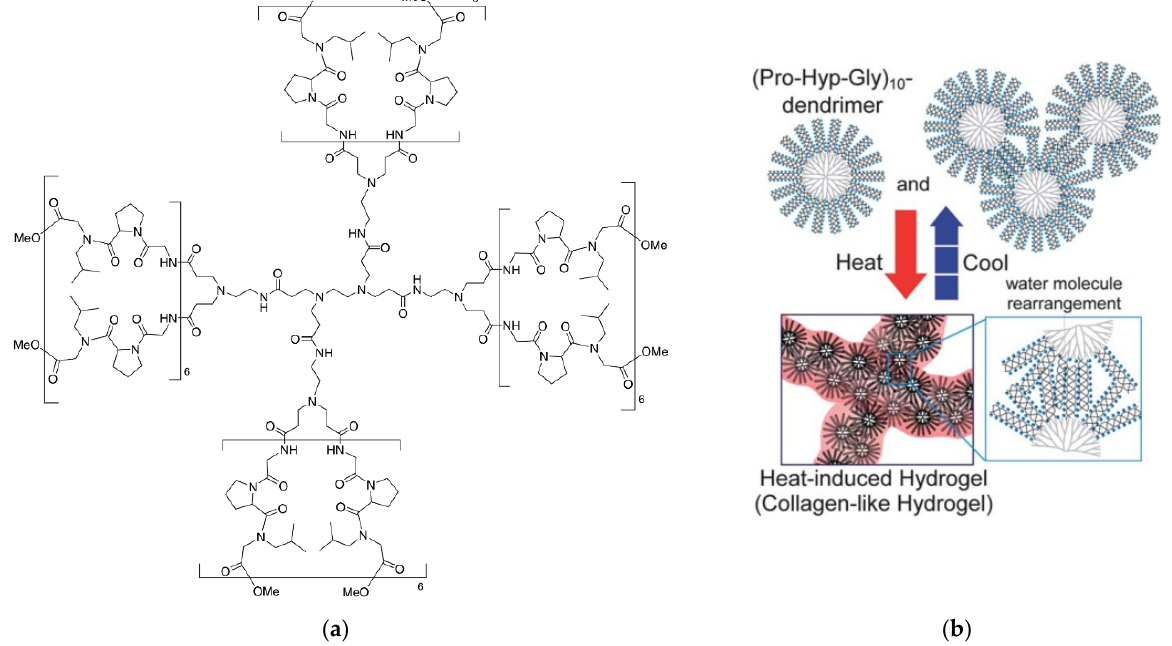
Figure 4. ( a ) Structure of PAMAMG0.5[(Gly-Pro-Nleu) 6 -OMe] 8 . Reproduced with permission from [120]. Copyright: Elsevier Ltd. ( b ) Gelation mechanism of the temperature-dependent G4 PAMAM [(Gly-Pro-Hyp)] 10 Reproduced with permission from [123]. Copyright: Royal Society of